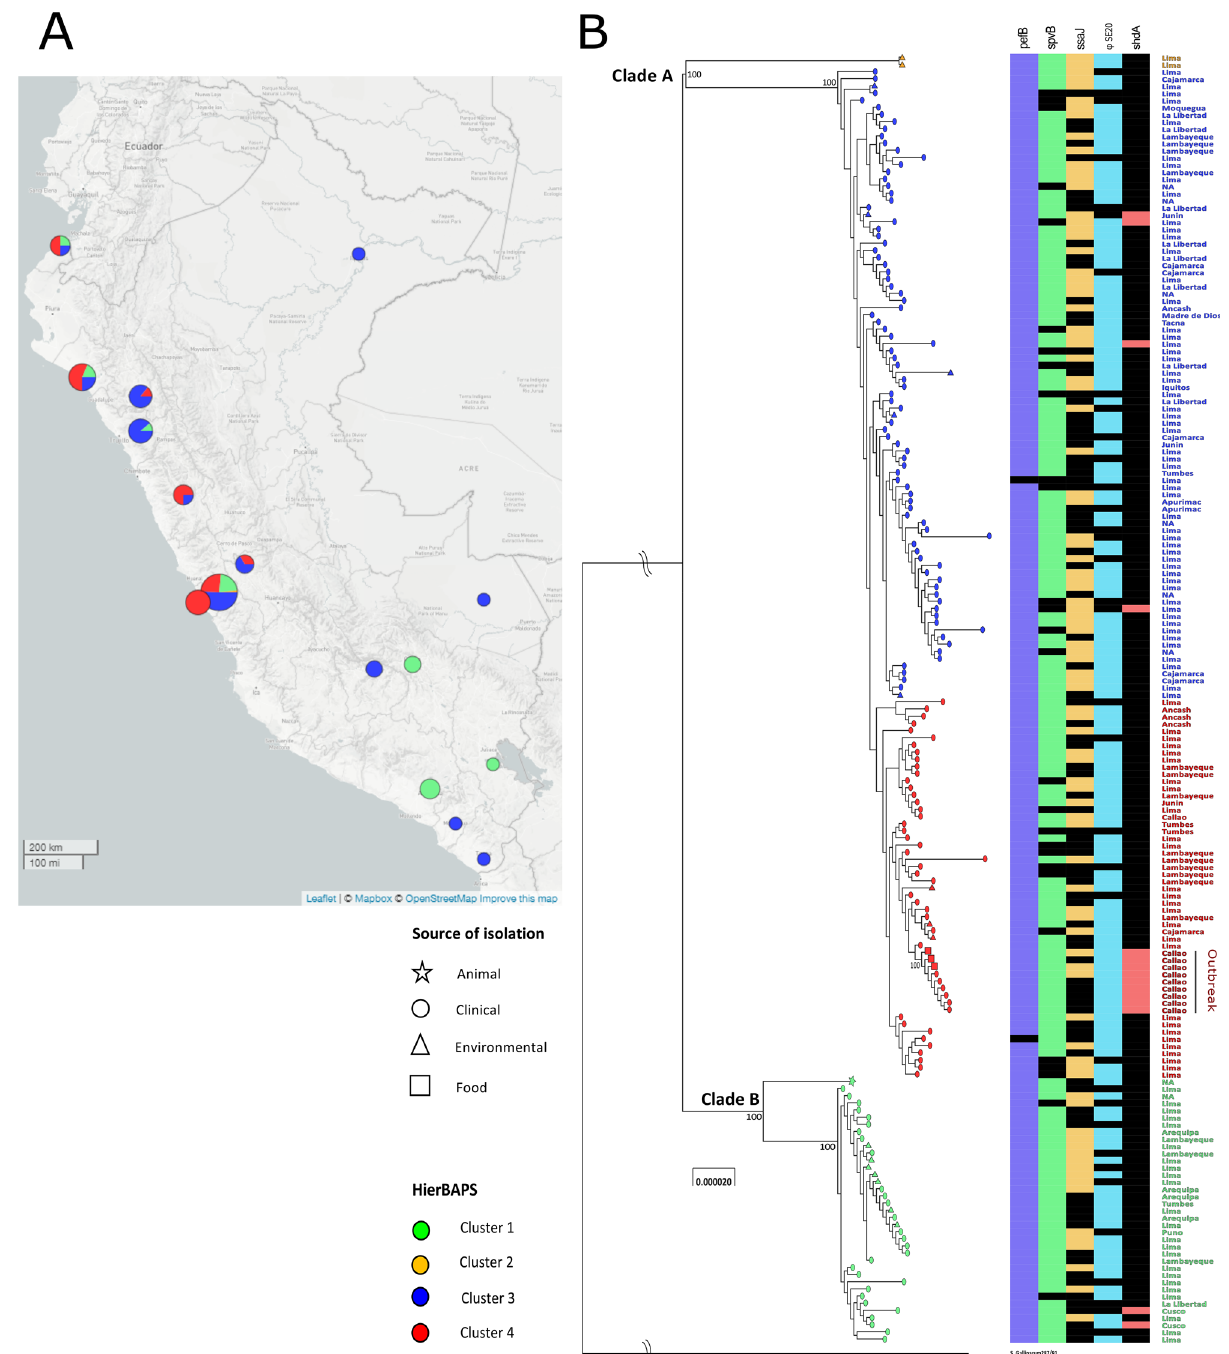
Figure 1. Phylogenomic analysis of Salmonella Enteritidis isolated in Peru from different sources. ( A ) Map of Peru and geographical locations of S. Enteritidis isolation generated using Microreact tool. The colors in each circular graph represent the four populations obtained with hierBAPS. ( B ) Maximum likelihood tree constructed based on LCBs, using the GTR + G model. The supporting nodes were calculated with a total of 1000 bootstrap. The shapes indicate the source of isolation and the colors are based on HierBAPS populations (see caption). In addition, the geographical origin of the strains and the presence or absence of the virulence factors and accessory genome are indicated next to each strain (Colored: Presence of the gene, Black: Absence of the gene). Both figures were obtained with the Microreact